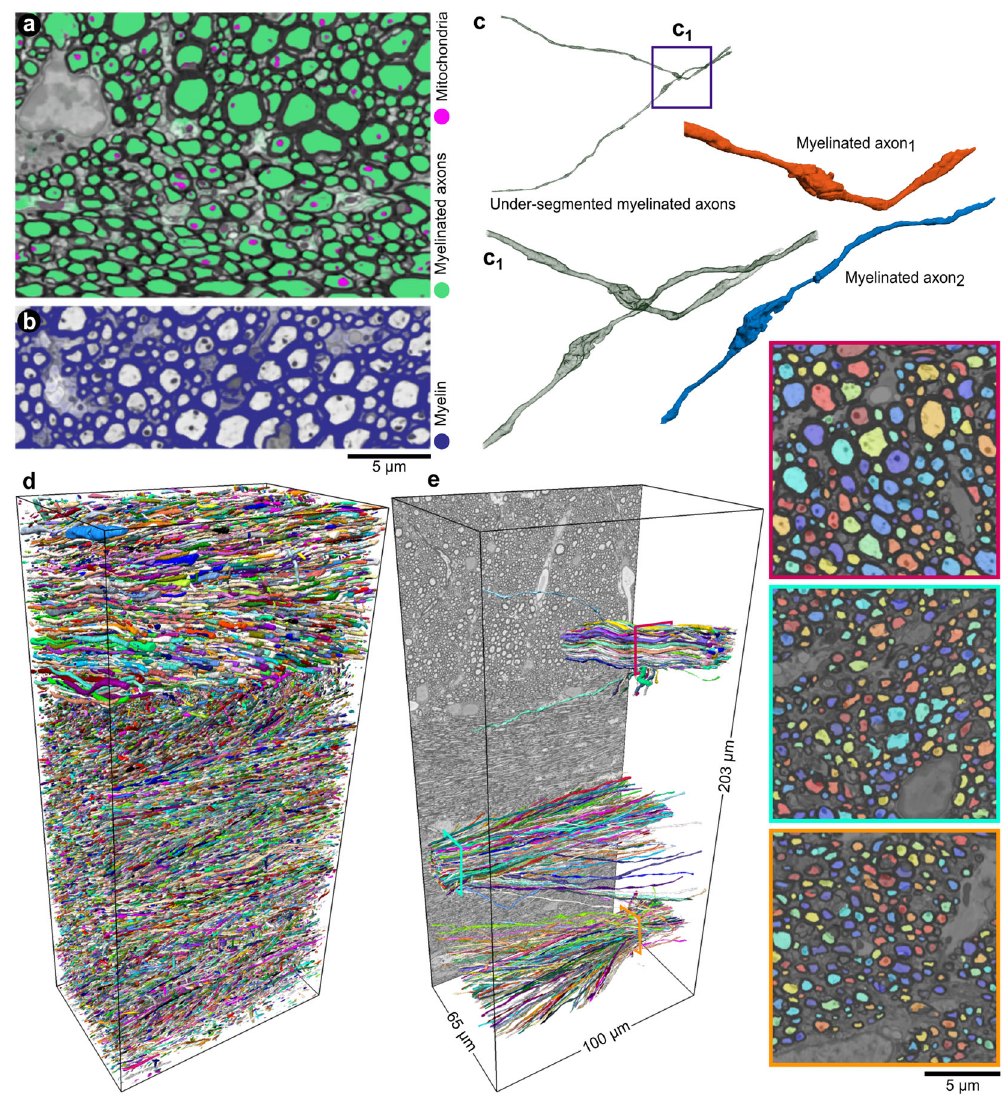
Fig. 3 DeepACSON segmentation of myelin, myelinated axons, and mitochondria. a , b The probability maps of myelinated axons, mitochondria, and myelin returned from DCNN-mAx, overlaid on their corresponding BM4D fi ltered images. c The CSD algorithm decomposed myelinated axons with erroneous merges. d 3D rendering of DeepACSON fi nal segmentation of myelinated axons (at one-third of the original resolution) in the contralateral corpus callosum and cingulum of sham # 25 low-resolution dataset. e 3D rendering of myelinated axons sampled at the corpus callosum and cingulum illustrates the variance of the axonal diameter among myelinated axons and the orientation dispersion in these